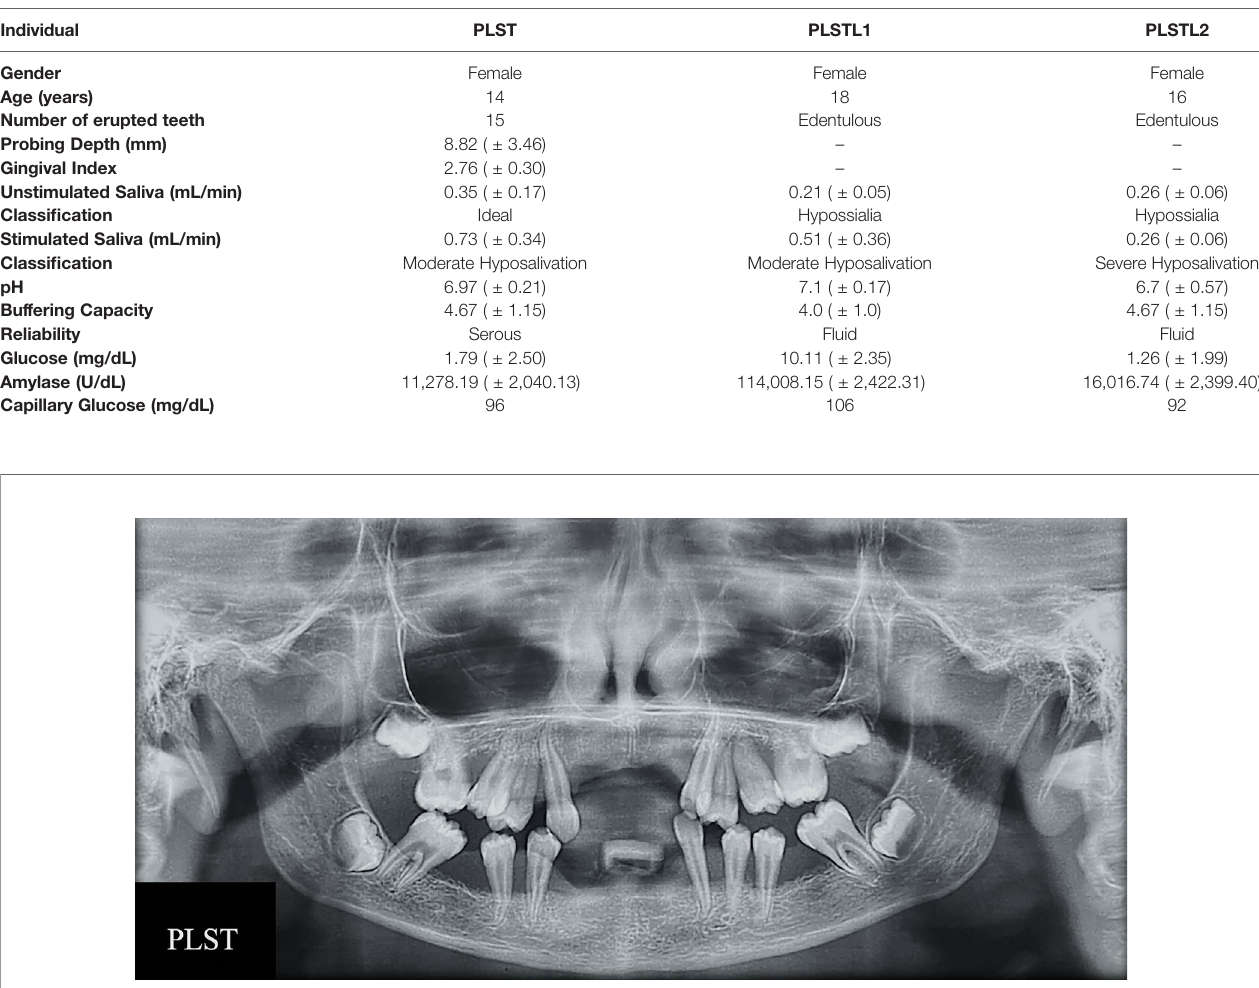
TABLE 1 | Baseline characteristics of the PLS individuals and salivary parameters, pH, buffering capacity, reliability, salivary fl ow, amylase activity, and glucose in Papillon – Lefèvre syndrome. Individual